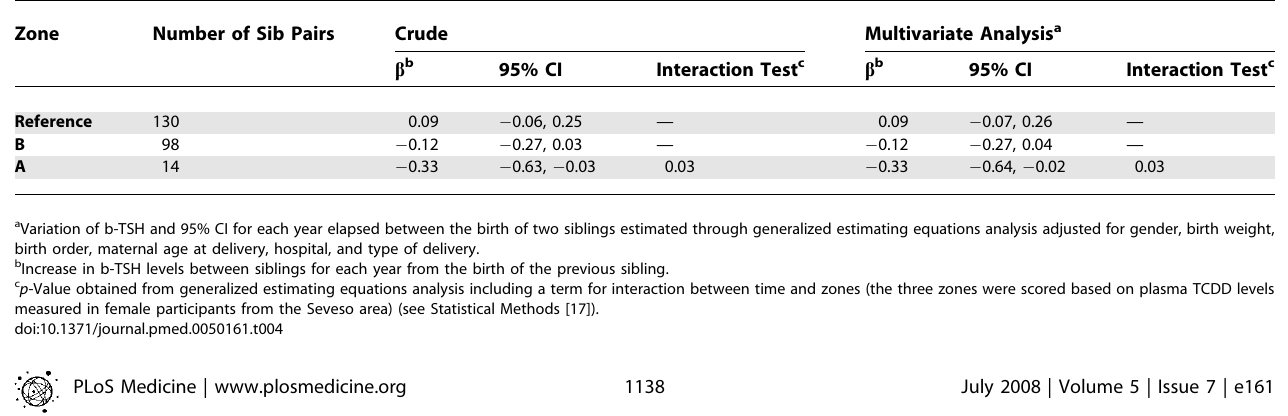
Table 4. Variations in Neonatal b-TSH between Siblings born between 1994 and 2005 to Women from Zone A, the Zone Most Contaminated after the Seveso Accident, Zone B, and the Surrounding Noncontaminated Area (Reference)